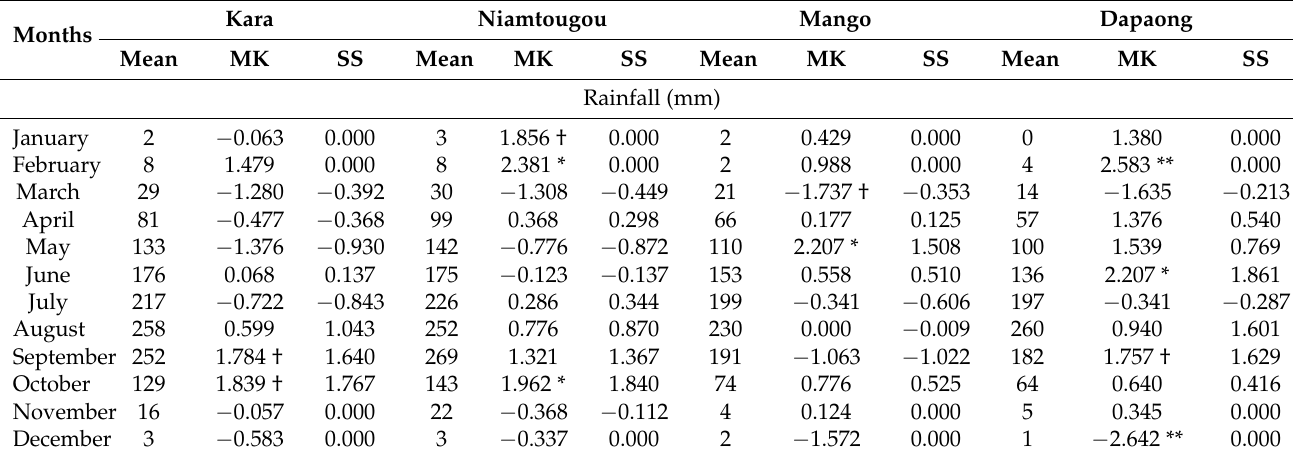
Table 6. Summary of the modified Mann–Kendall (MK) test and Sen’s Slope test (SS) (Trend-Free Pre-Whitening) of the monthly rainfall (mm) in Kara, Niamtougou, Mango and Dapaong.